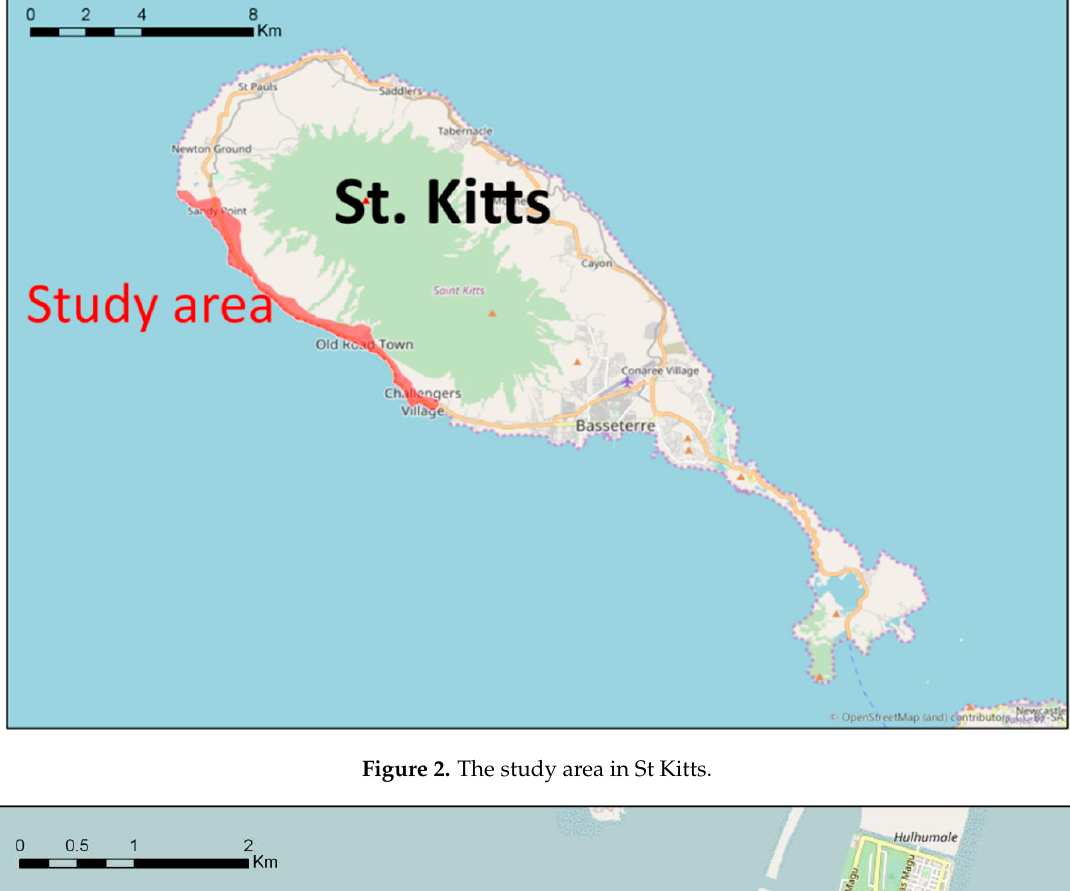
Figure 2. The study area in St Kitts.